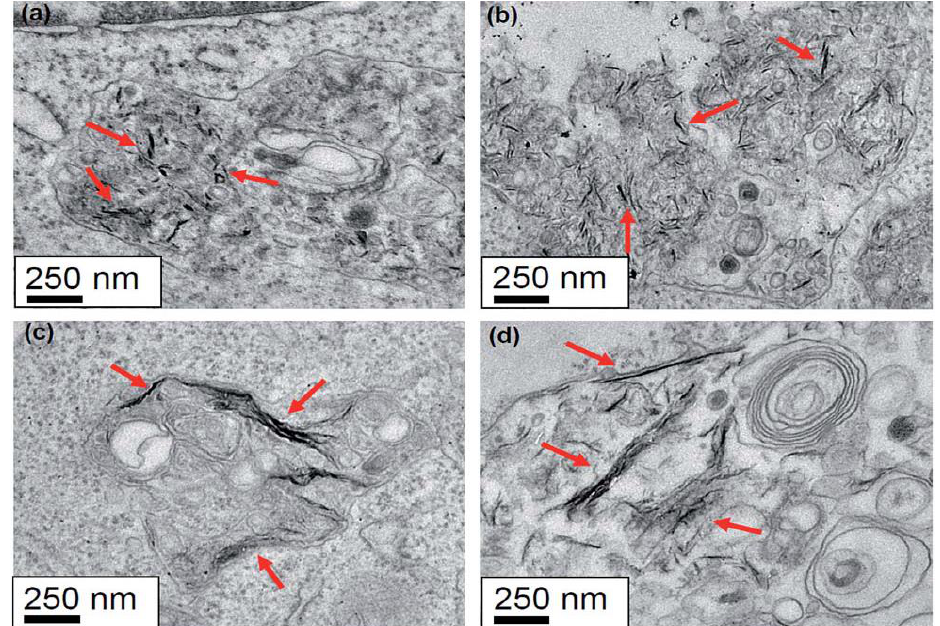
Figure 12. ( a , b ) are TEM images of a macrophage cultivated with small GOs for 12 and 48 h, respectively. ( c , d ) are TEM images of a macrophage cultured with large GOs for 12 and 48 h, respectively. GO flakes with sizes of 89 and 277 nm are internalized by a macrophage, as indicated by the arrows. Reproduced from [111] with permission of the Royal Society of Chemistry.